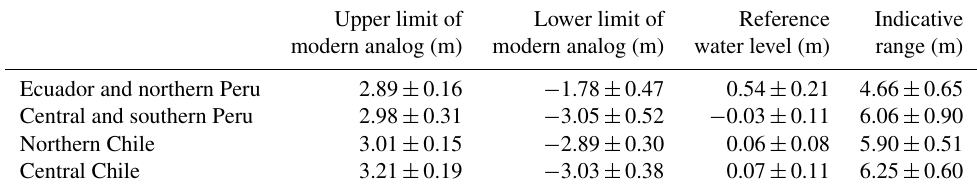
Table 2. Median values and standard deviations (2 σ ) representing the indicative meaning along the WSAC. The four sectors were chosen based on their main geomorphic characteristics (see Sect.